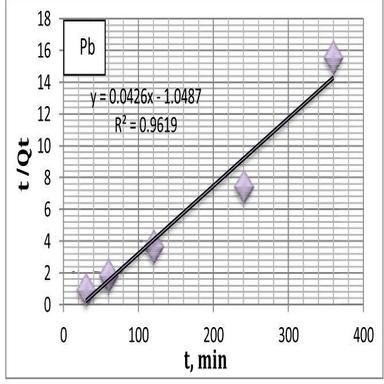
Plot of pseudo-second order reaction for adsorption of heavy metals by SiO2@C nanocomposite (SC1).